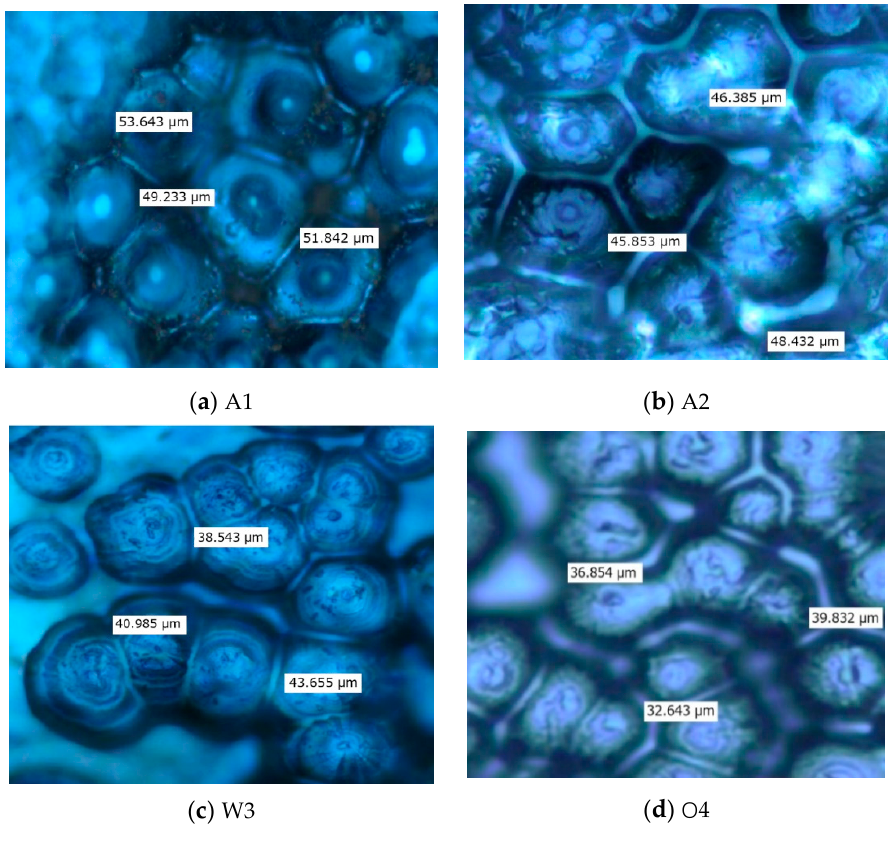
Figure 1. PLM pictures of LDPE.